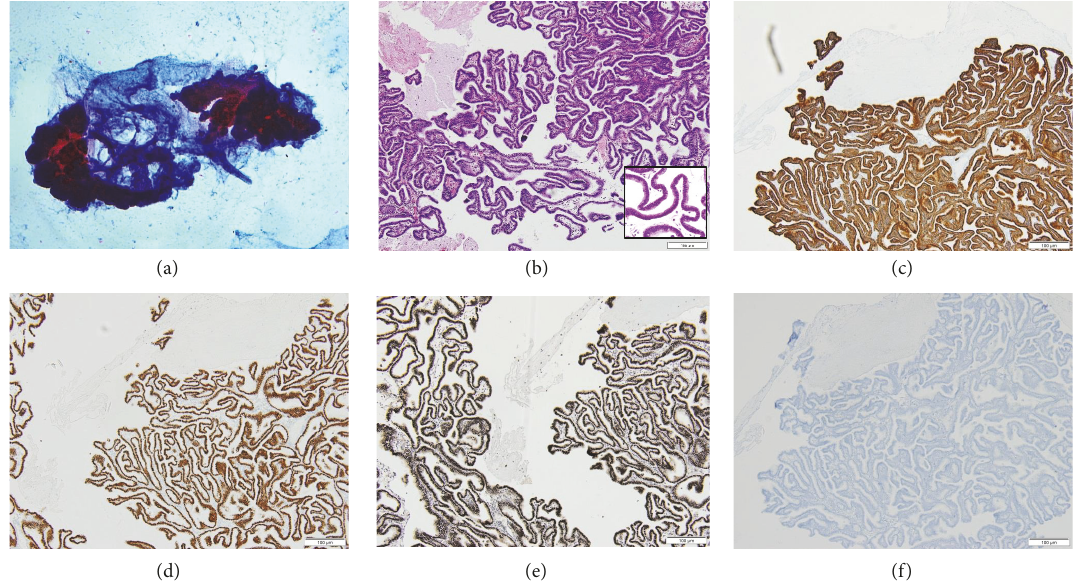
Figure 2: (a) Neoplastic cells forming papillary clusters with smooth contoured edges (b) Serous borderline tumor with hierarchically branched papillae lined by polygonal to columnar serous epithelium with mild atypia (inset) Immunohistochemistry showed (c) CK7 cytoplasmic positivity (d) PAX8 diffuse nuclear positivity (e) WT-1 diffuse nuclear positivity (f) CK20 negative